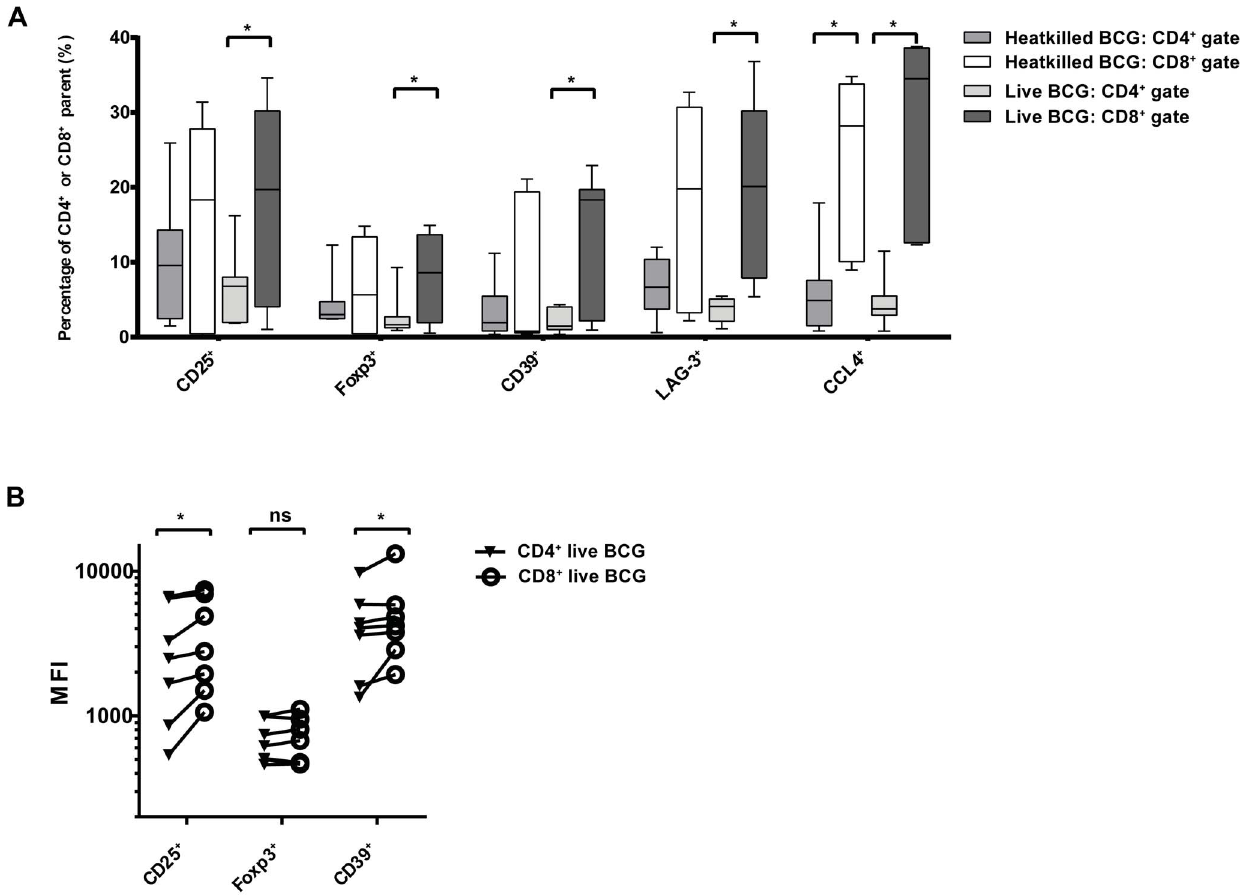
Figure 2. Treg-cell marker frequency and density are increased on live BCG-activated CD8 + vs. CD4 + T cells. A: BCG induces Treg-cell marker expression on CD4 + and CD8 + T cells; after live BCG stimulation the percentage of total CD8 + T cells expressing CD25, Foxp3, CD39, LAG-3 or CCL4 is significantly higher compared to CD4 + T cells, depicted here as frequency of CD8 + or CD4 + population. Differences in Treg marker expression between heatkilled BCG–activated CD8 + vs. CD4 + T cells were not significant, except for expression of CCL4; CCL4 expression was also significantly higher on CD8 + T cells compared to CD4 + T cells in samples not stimulated with BCG (Fig. S1) ( *p , 0.05, Wilcoxon signed-ranks test). B: Mean fluorescence intensities (MFIs) of CD25 and CD39 are increased on live BCG-activated CD8 + T cells as compared to CD4 + T cells. Gating was performed as demonstrated in figure 1A. To assess differences in intrinsic intensity of expression on CD4 + and CD8 + T cells, respectively, MFIs of positive Treg marker populations in samples not stimulated with BCG were compared; this was similar on CD4 + and CD8 + T cells for MFIs of CD25, Foxp3 and CD39. Data are representative of seven in vitro PPD-responders six days after heatkilled or live BCG stimulation (* p , 0.05; Wilcoxon signed-ranks test).